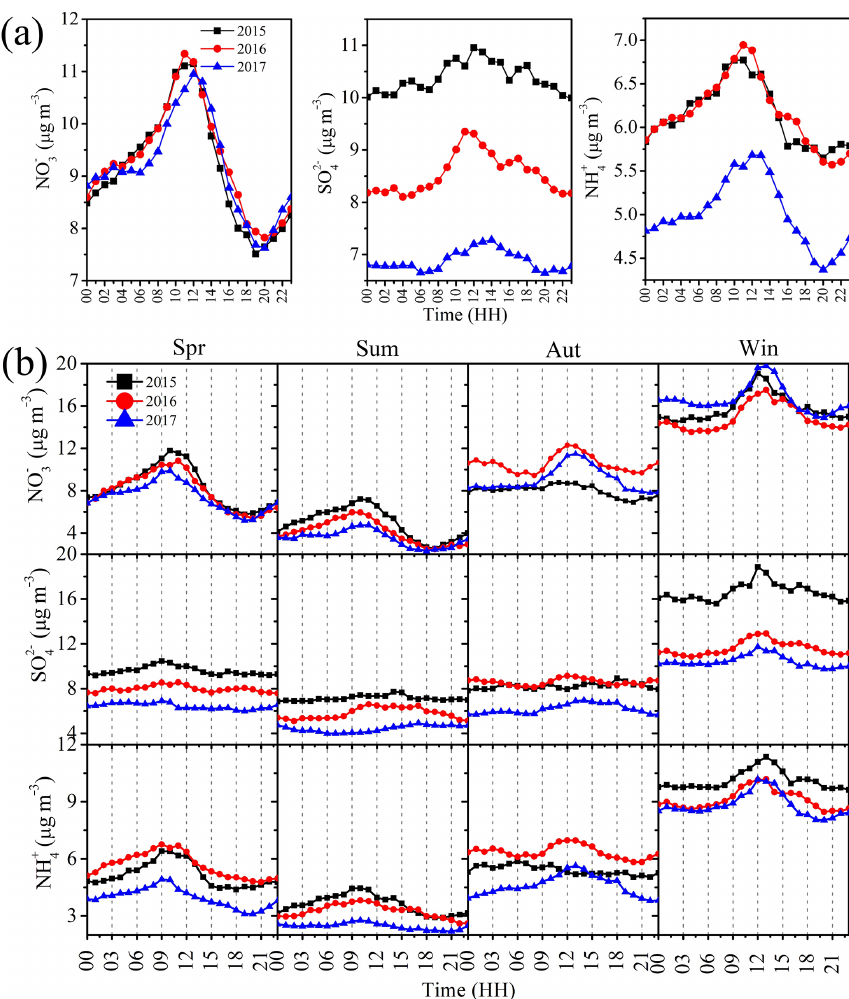
Figure 5. Diurnal variations in NSA (nitrate, sulfate and ammonium) from 2015 to 2017. (a) Annual average. (b) Seasonal